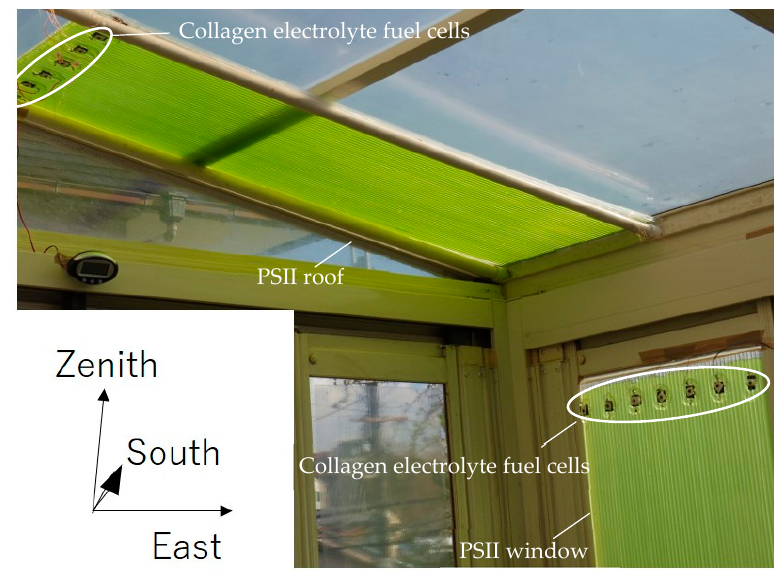
Figure 6. Photograph of the PSII roof and the PSII window.